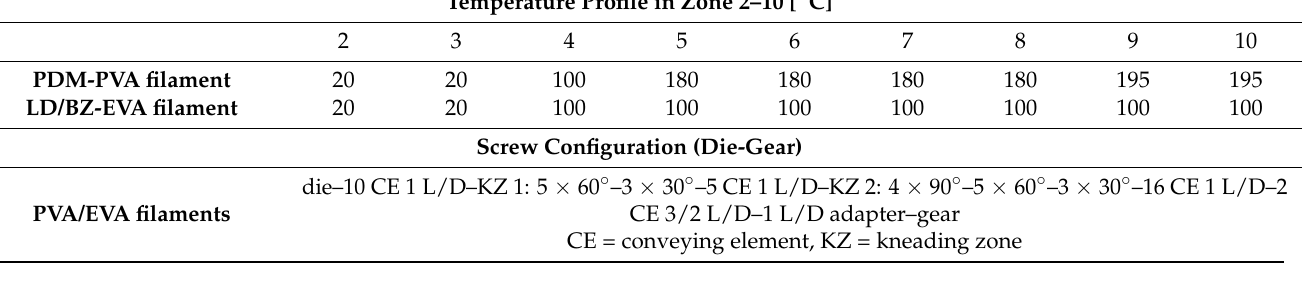
Table 4. Extrusion parameters with adjusted temperatures during extrusion and screw configuration of performed extrusions.